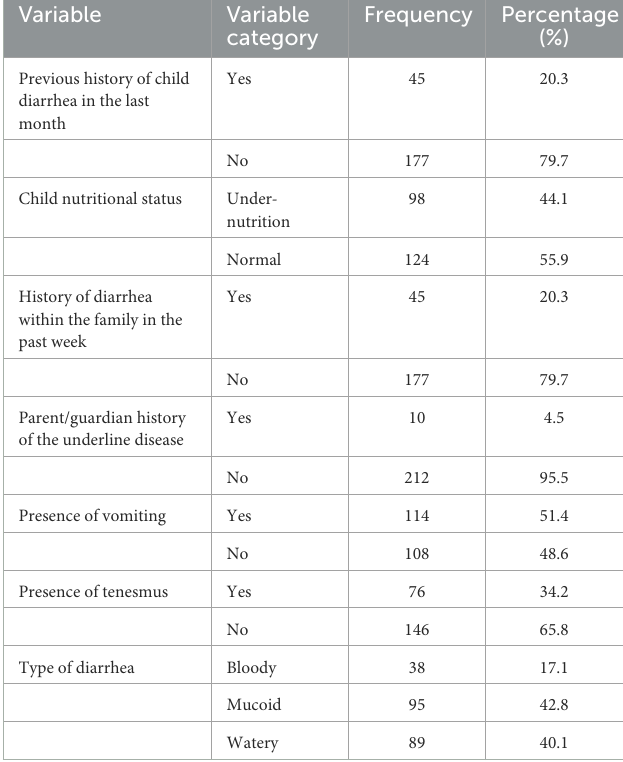
TABLE 2 Clinical characteristics of the study participants in public health facilities in Debre Markos town,